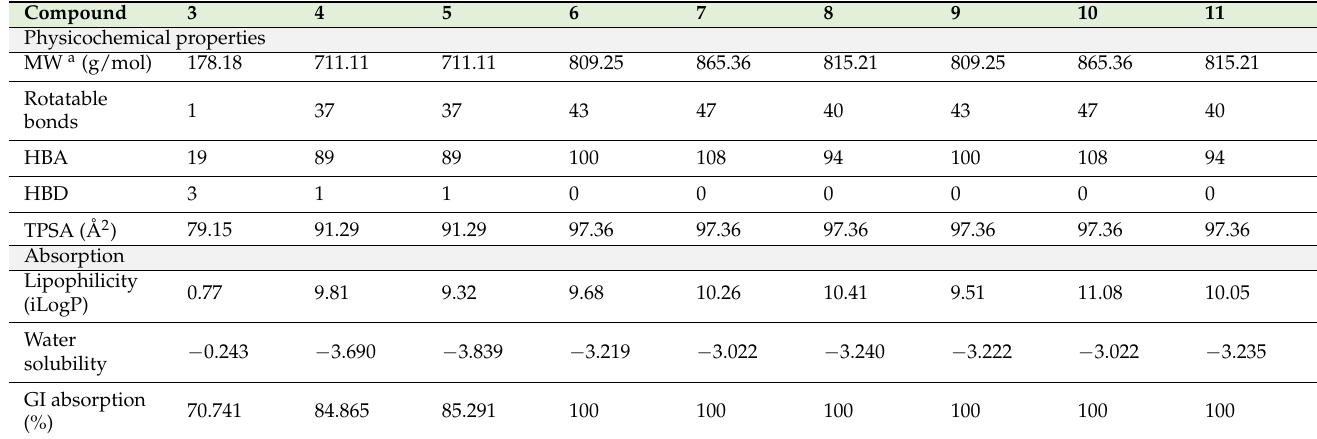
Table 5. Predicted physicochemical, ADMET, and drug-likeness profile of rhamnopyranoside